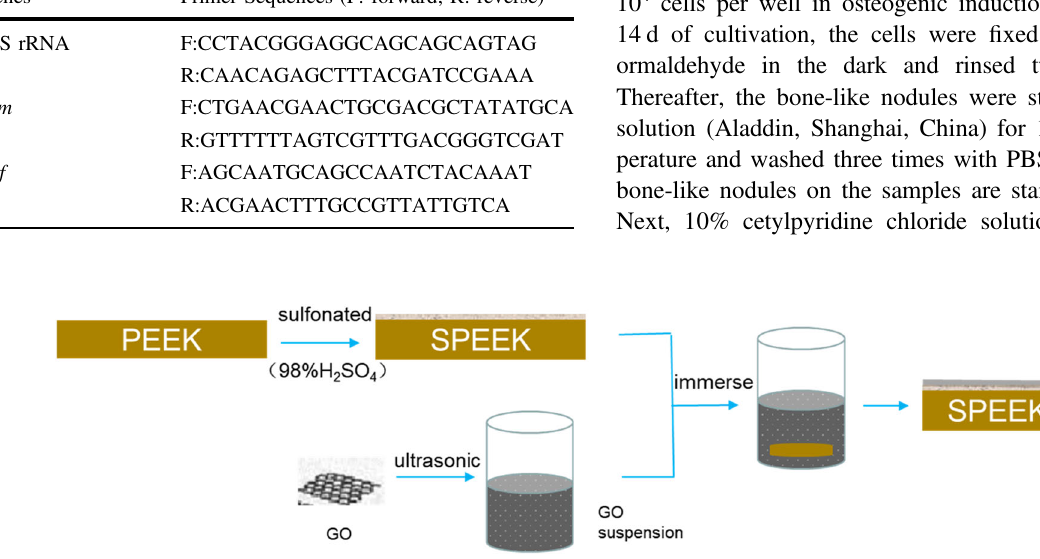
Table 1 Primer sequences for RT-PCR of oral pathogenic genes